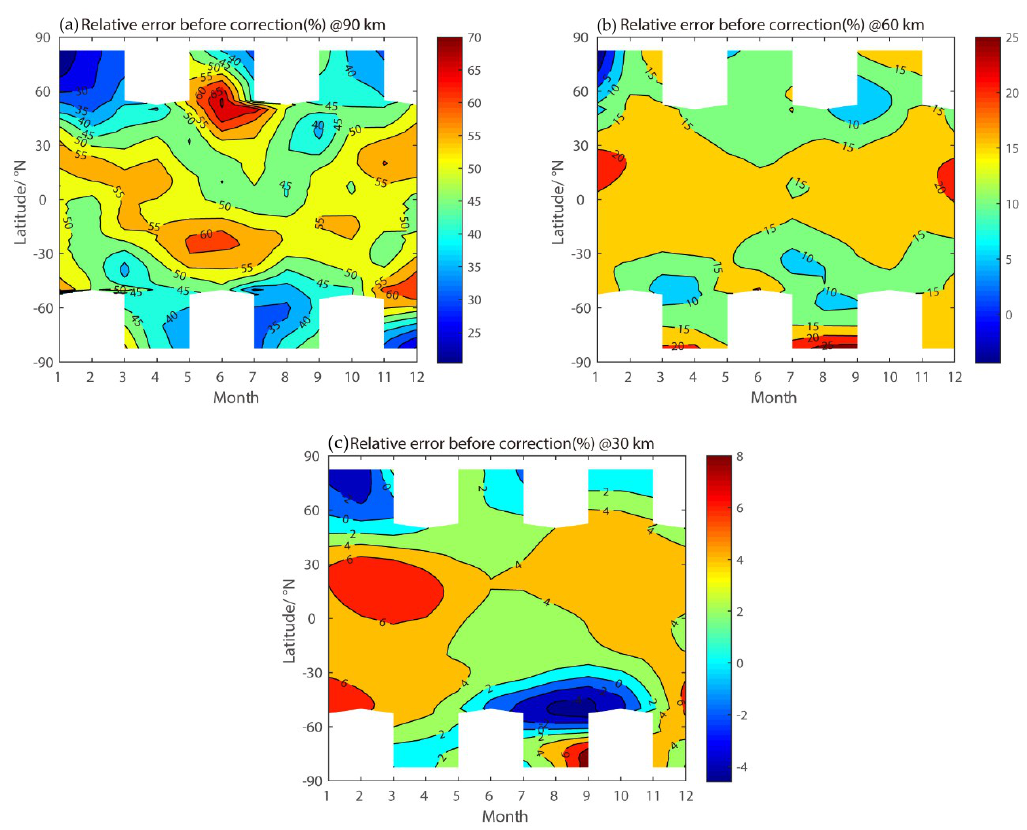
Figure 1. The latitude versus month variations of zonal mean relative difference between NRLMSISE-00 and TIMED/SABER density before correction at ( a ) 90, ( b ) 60, and ( c ) 30 km. As shown in Figure 2, the relative error in model density increases with height for the same latitude. The relative error at middle and low latitudes is higher than that at high latitudes from 80 to 100 km. Near the equator in January, the maximum relative error of the model reaches 79% at 100 km. From 45–80 km, the relative error of the model in the northern hemisphere is greater than that in the northern hemisphere. In July, the relative error is mainly around 50%, with the maximum reaching 68% at 80-100 km. From 45 to 80 km, the relative error of the model at middle and low latitudes in the northern hemisphere is greater than that at high latitudes in the northern hemisphere.